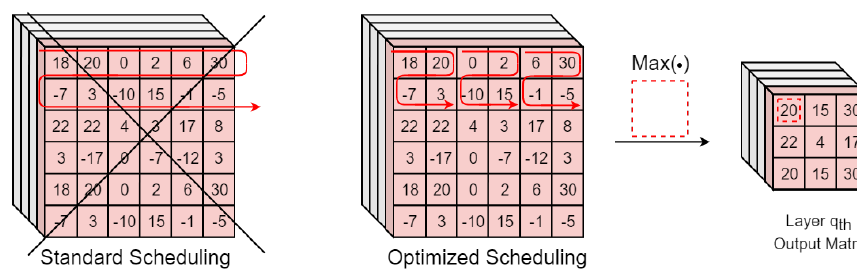
Figure 6. Standard scheduling versus optimized scheduling for P q =